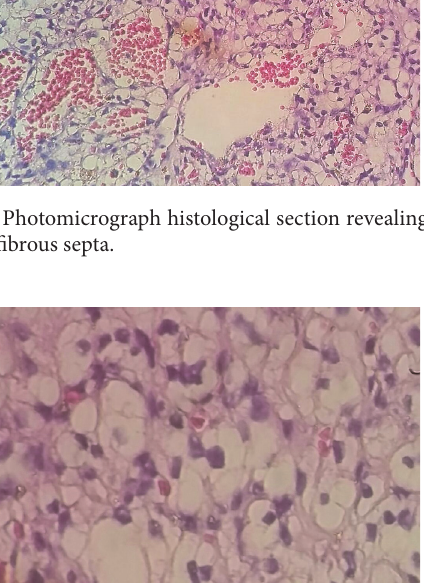
Figure 2: Contrast-enhanced CT scan (corticomedullary phase): complex cyst compatible with a Bosniak III cystic renal mass.